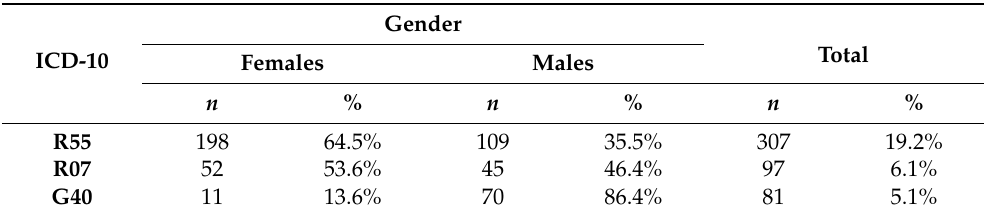
Table 4. Top 10 ICD-10 diagnoses used by emergency medical services teams during workplace interventions by